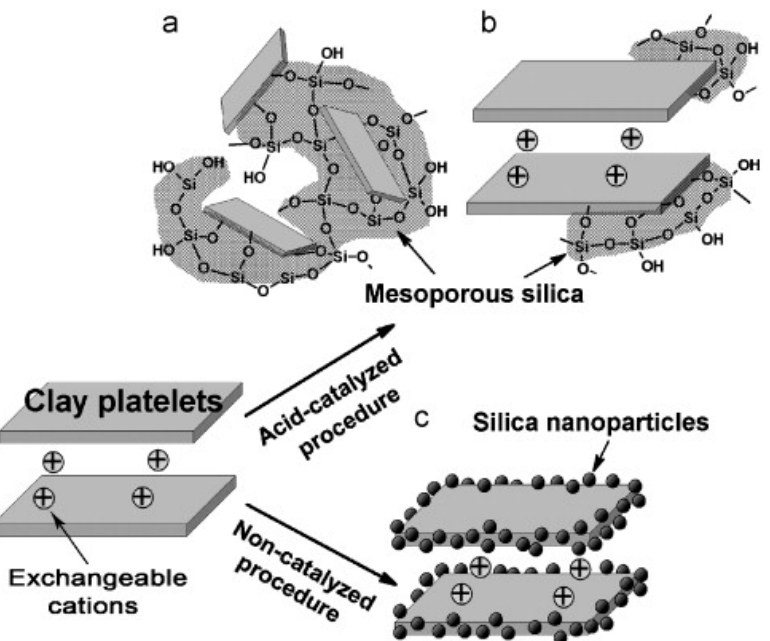
Figure 6. Schematic representation of the proposed structural models for the sol-gel-modified clays in the case of acid-catalyzed procedures: ( a ) a cross-linked structure at high TEOS/clay ratio; ( b ) mesoporous silica attached on clay surface at low TEOS/clay ratio, and in the case of non-catalyzed procedures: ( c ) silica nanoparticles attached on clay surfaces. Reprinted with permission from [34]. Copyright 2008 Elsevier B.V.